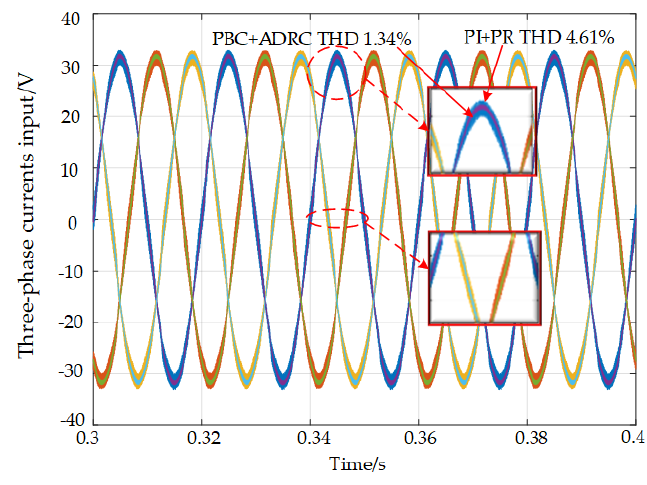
9 Figure 9. Comparison of three − phase input current under different control strategies.